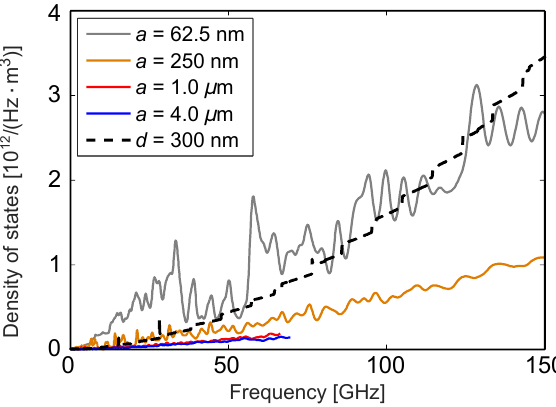
Figure 5. Phonon density of states of a full membrane and four PnC membranes with the same thickness and different lattice constants. The PnC curves are smoothed for visual